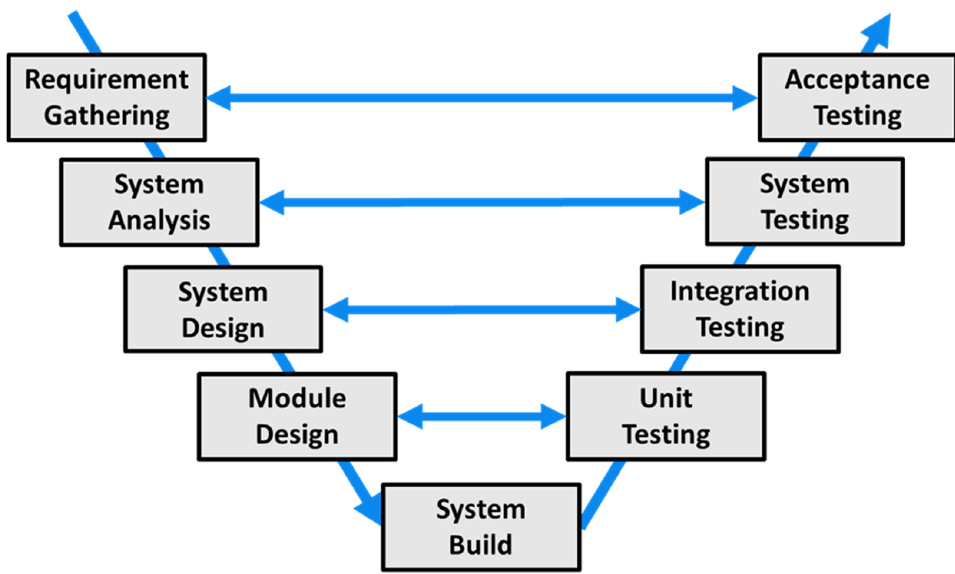
Figure 1. GAMP 5